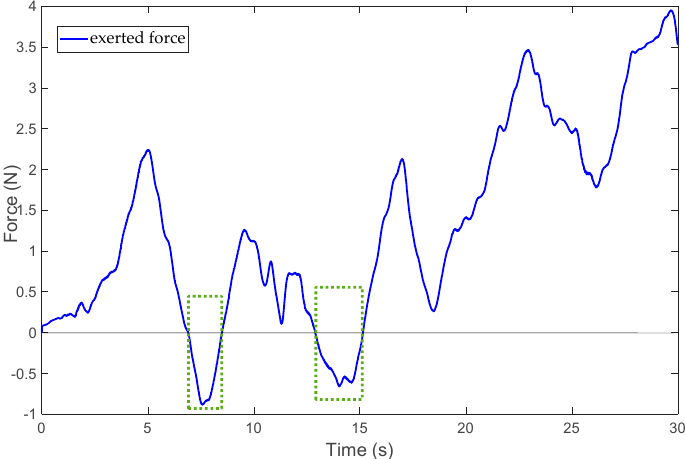
Figure 12. Position of the orange and purple objects in the visual model.